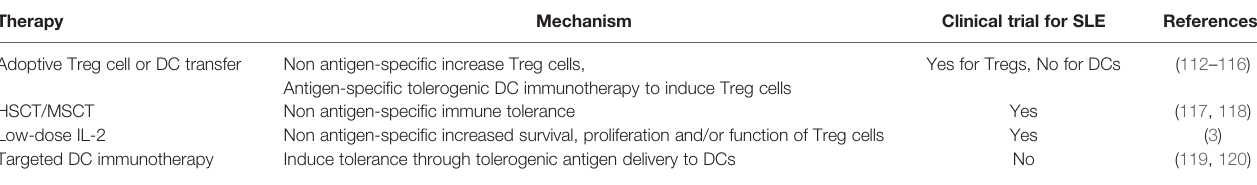
TABLE 1 | Treg and DC based Therapies without